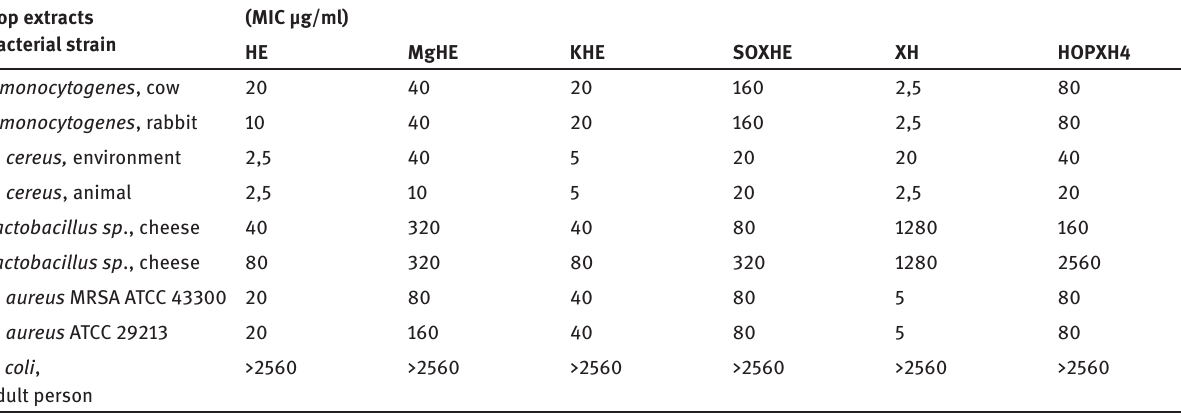
Table 4: Antimicrobial activity of the investigated hops extracts [supercritical CO (MgHE); ScCO extract isomerized by KOH (KHE); non-polar hops extract (Sohxlet extraction) SOXHE; xanthohumol (XH, 96%) and ScCO 2 with XH content up to 6.5% (XH4)], against L. monocytogenes , brain specimen, cow; L. monocytogenes , brain specimen, rabbit; B. cereus, swab from the environment; B. cereus , skin swab animal ; Lactobacillus sp ., cheese; Lactobacillus sp. cheese; S. aureus MRSA ATCC 43300; S. aureus ATCC 29213; Escherichia coli , adult with